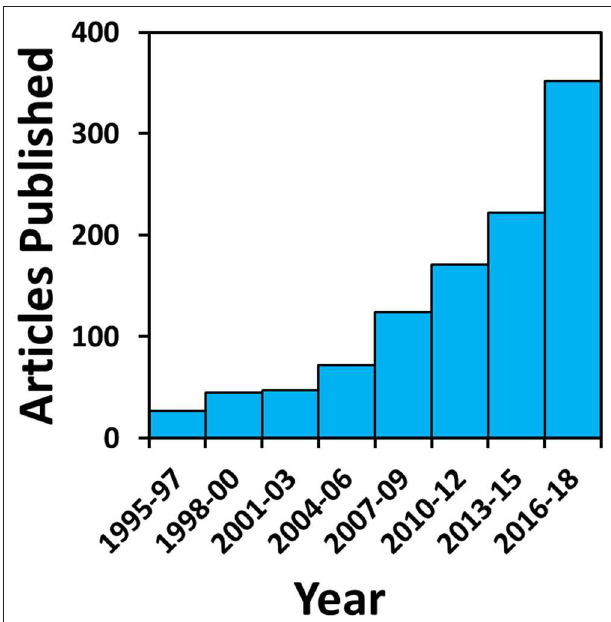
FIGURE 1 | Growth in archaeology publications with isotope analyses. Data generated using key word searches in the Journal of Archaeological Science (JAS) and Journal of Archaeological Science